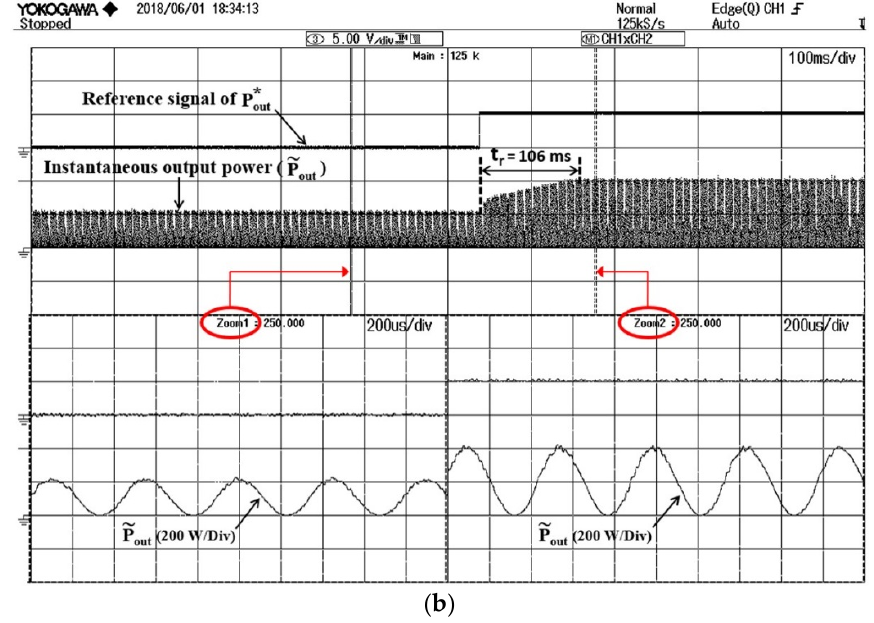
Figure 10. Experimental results of the output power step response: ( a ) Proposed model predictive control (MPC); ( b ) PI control.